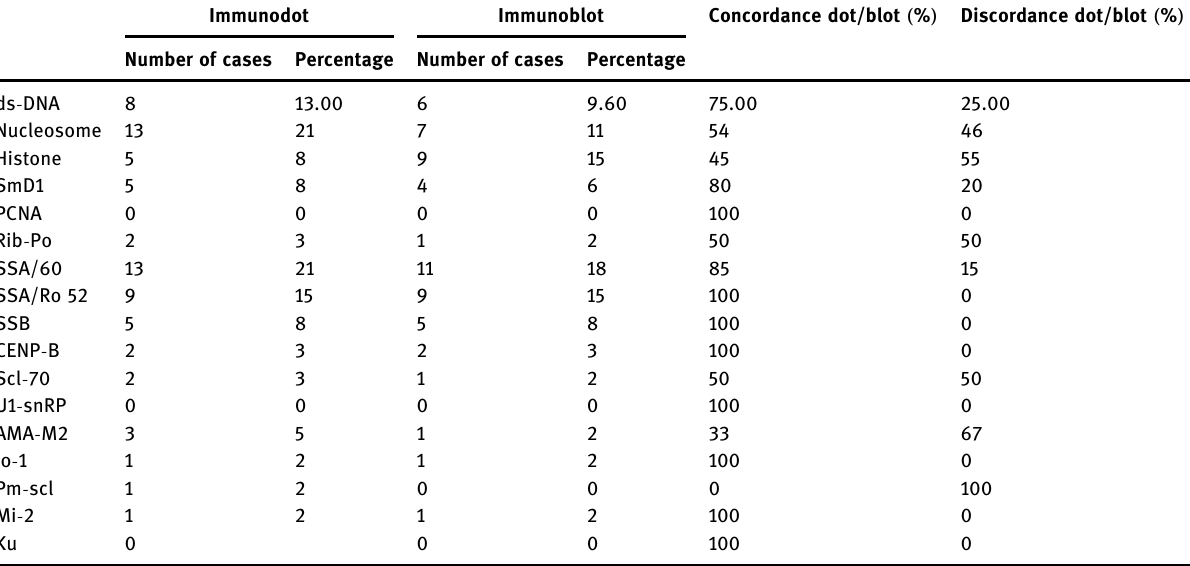
Table 1: Study of concordance and discordance between immunodot and immunoblot